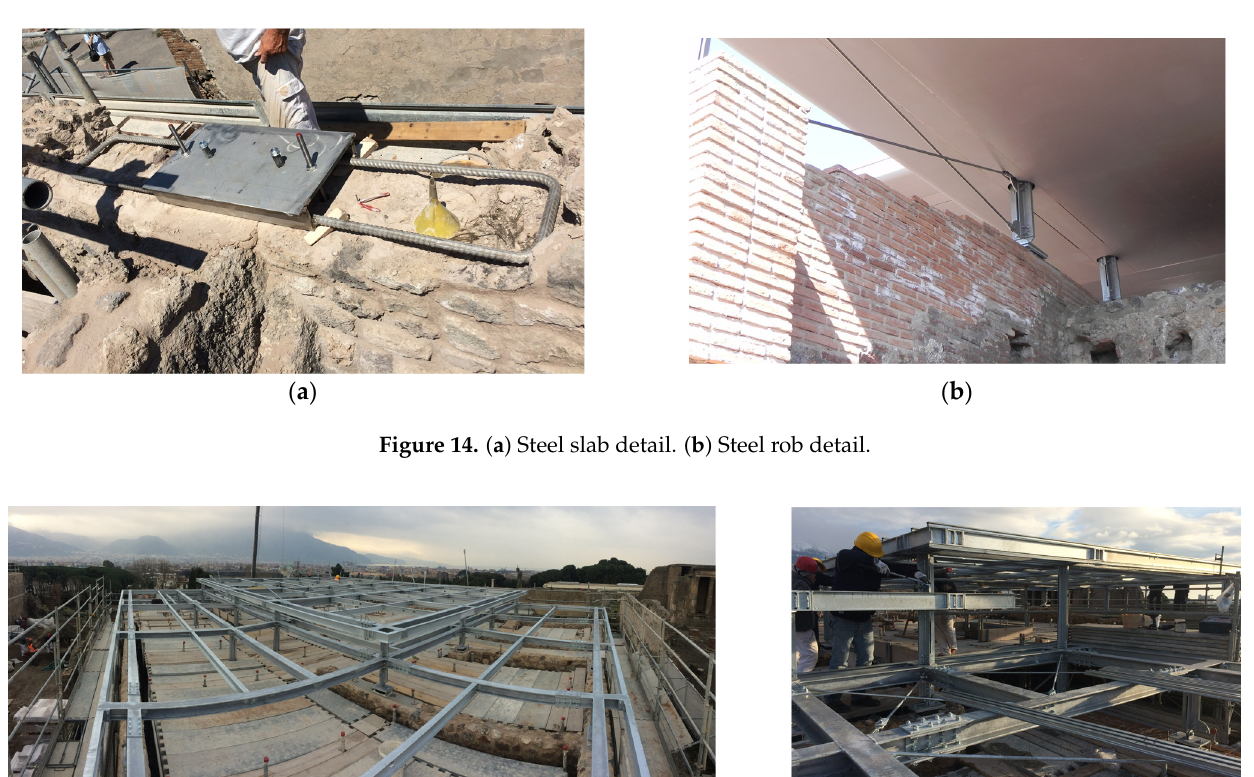
Figure 13. Structural design. ( a ) Detail of the roofs in plane.( b ) Joint detail.